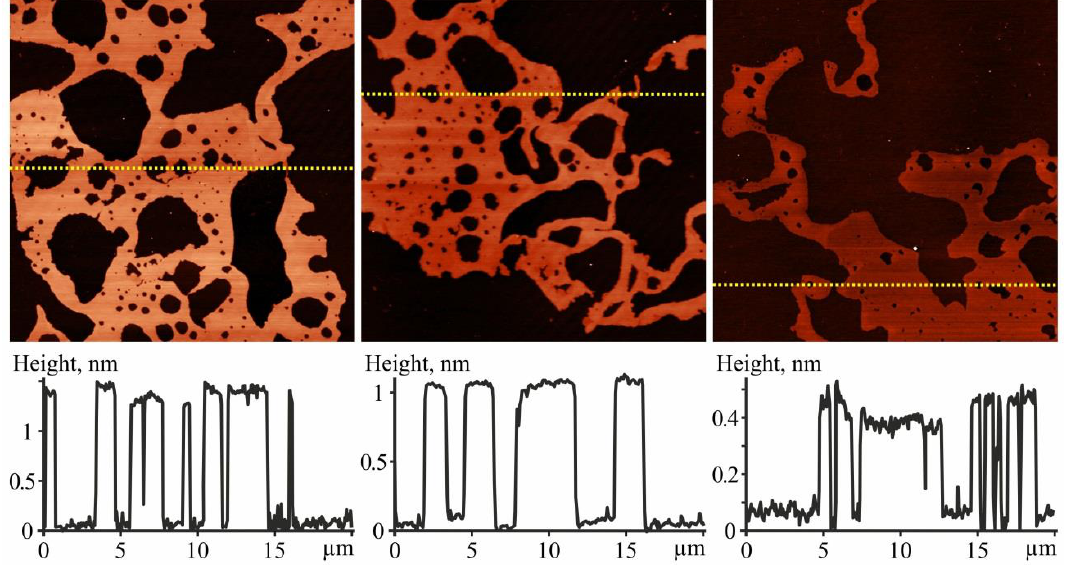
Figure 4. AFM images of the Ber (concentration 208 µM) layer ( top ) and their Z-profiles along the lines marked on images ( bottom ); image size is 20 × 20 µm 2 .